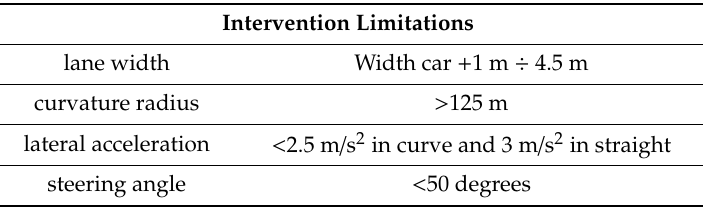
Table 1. Intervention specifications.